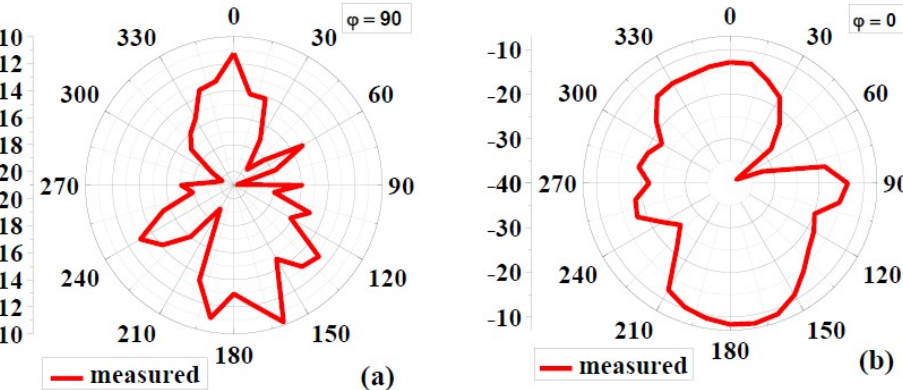
Figure 9. Simulated 2D radiation pattern of the proposed antenna with AMC at 8.6GHz: ( a ) φ = 90 and ( b ) φ = 0.